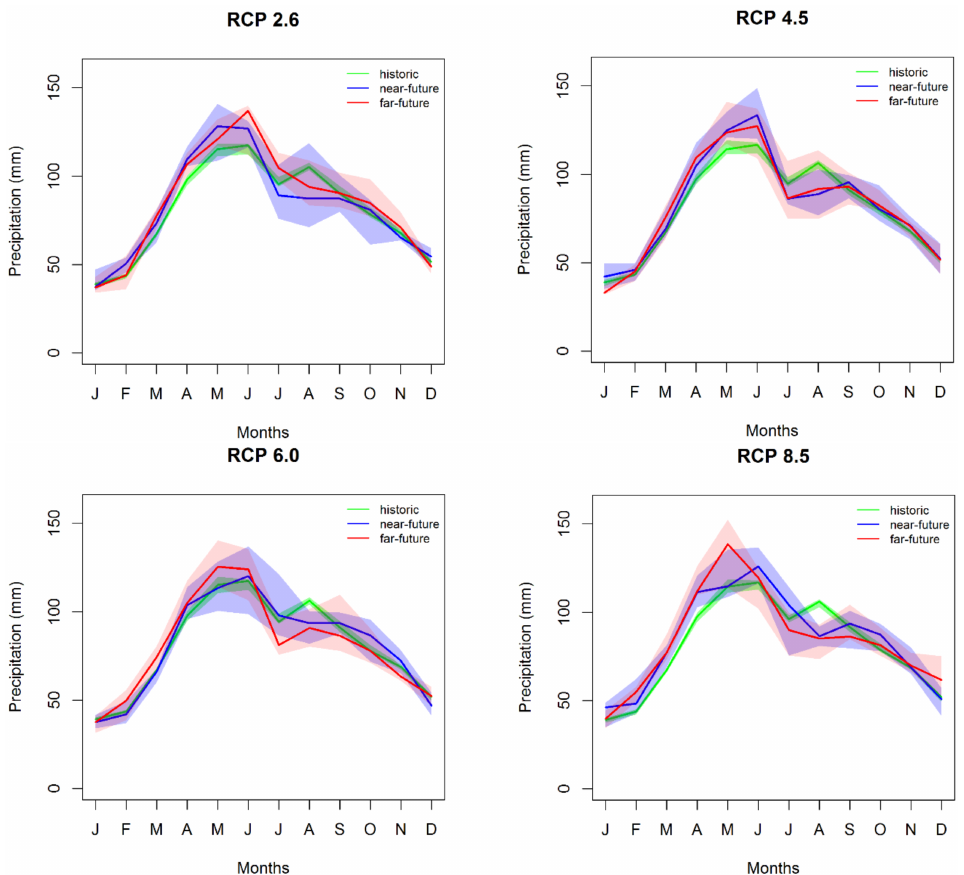
Figure 7. Monthly ensemble median and quartile of downscaled monthly precipitation for historic and future projections in Goodwater Creek Experimental Watershed. The median is represented by the solid line with Q1 represented by the lower bound of the shaded region and Q3 represented by the upper bound of the shaded